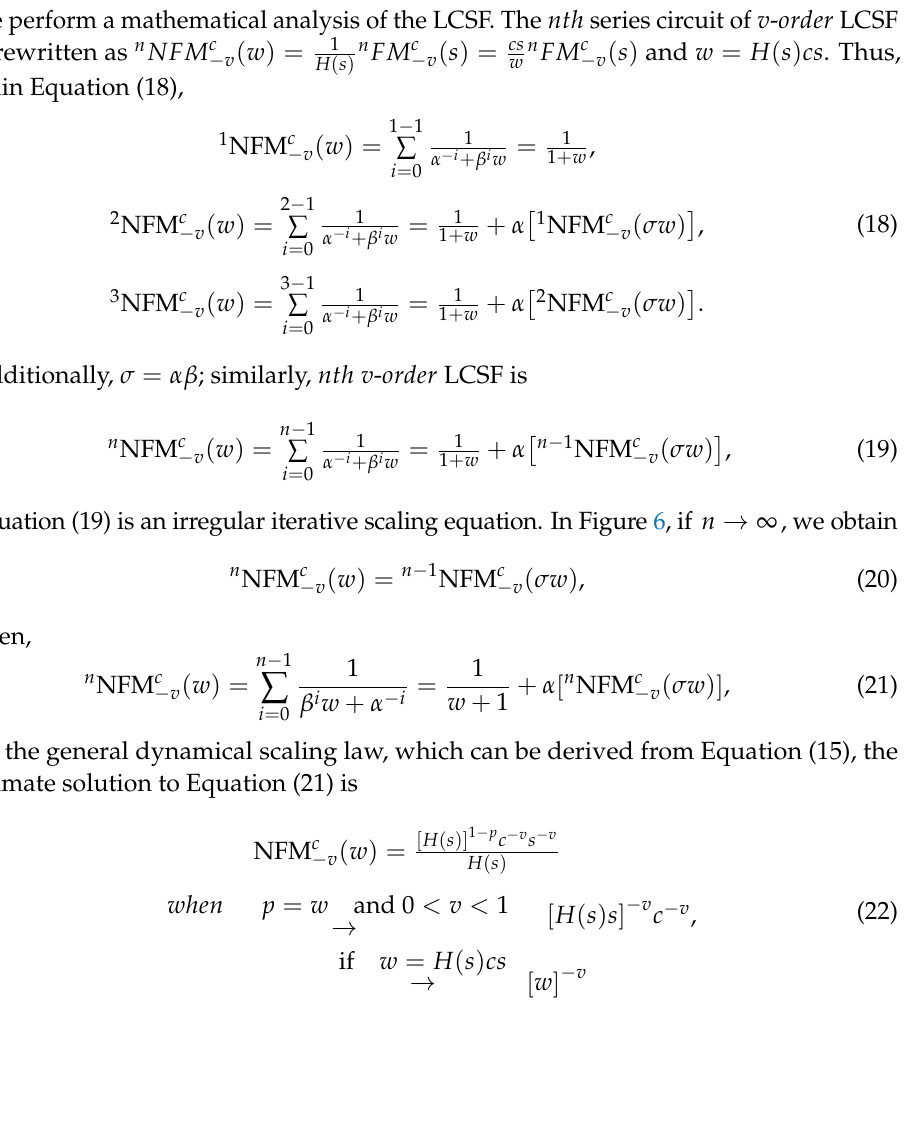
Figure 5. ( a ) Low-pass capacitive fracmemristor; and ( b ) high-pass capacitive fracmemristor.